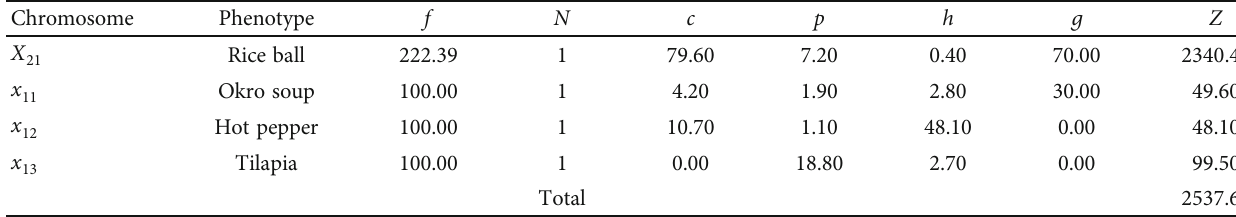
Table 5: Sample chromosome representation of child meal X